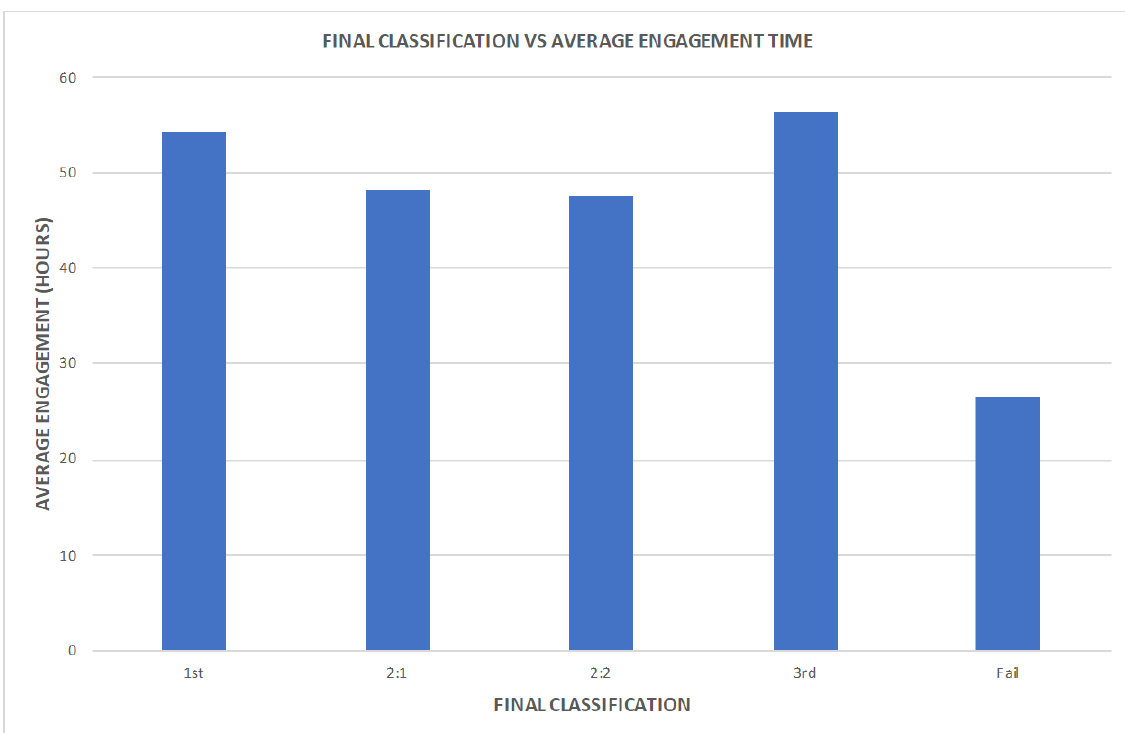
Figur e 9 . Final Classification vs Total Engagement